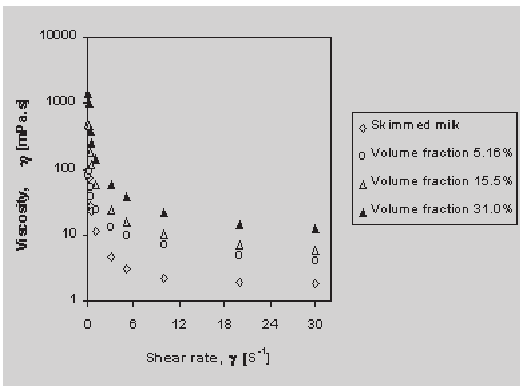
Figure 3: Flow curves of milk fat in skimmed milk